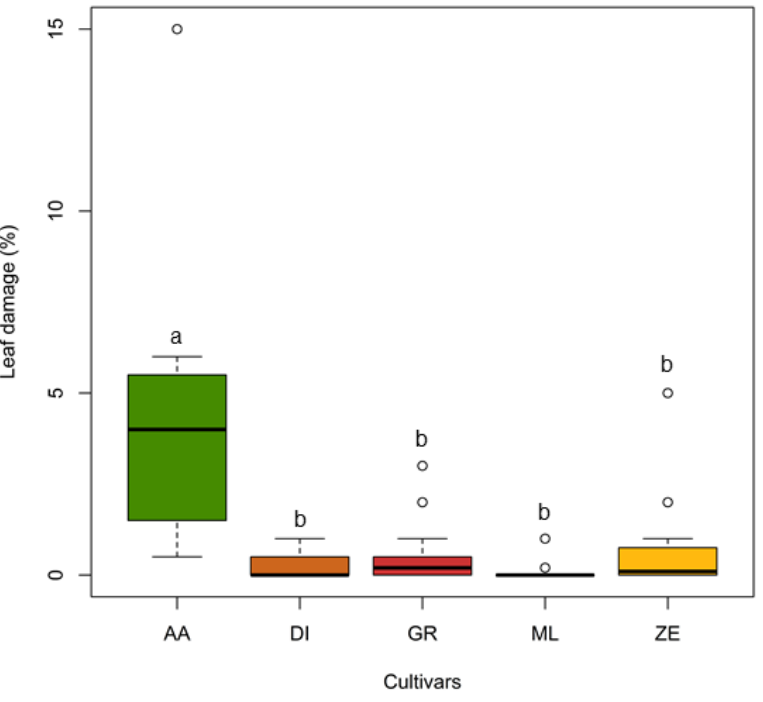
Figure 4. Comparisons of leaf damage in M. sinensis cultivars from grasshopper herbivory during the cage experiment at the Research Plant Growth Facility of the University of Maryland (College Park, MD, USA) in 2018. Box plots represent measurements of the percentage of apparent leaf damage in different M. sinensis cultivars; leaf damage measurements that do not share a letter is significantly different (Dunn test: p < 0.05; the Kruskal–Wallis test followed by post hoc Dunn test was used).